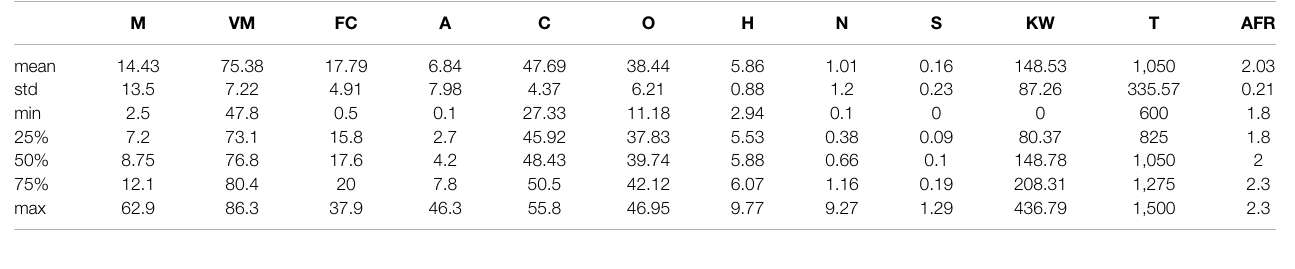
TABLE 3 | Dataset statistics.